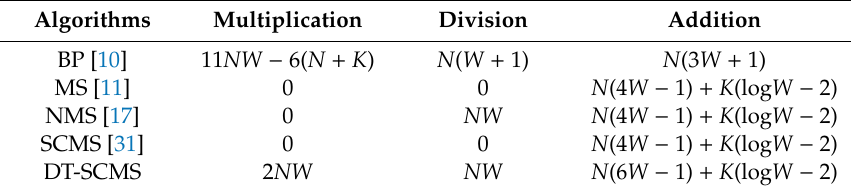
Table 5. Computational complexity of decoding algorithms.